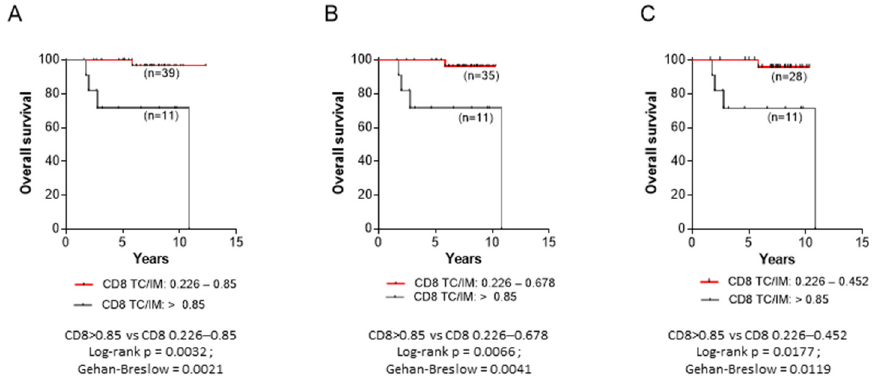
Figure 8. Correlations between CD8+ TC/IM ratios and overall survival for patients with ( A ) CD8+ TC/IM ratios between 0.226–0.85 and CD8+ TC/IM ratios above 0.85. ( B ) CD8+ TC/IM ratios between 0.226–0.678 and CD8+ TC/IM ratios above 0.85. ( C ) CD8+ TC/IM ratios between 0.226–0.452 and CD8+ TC/IM ratios above 0.85.